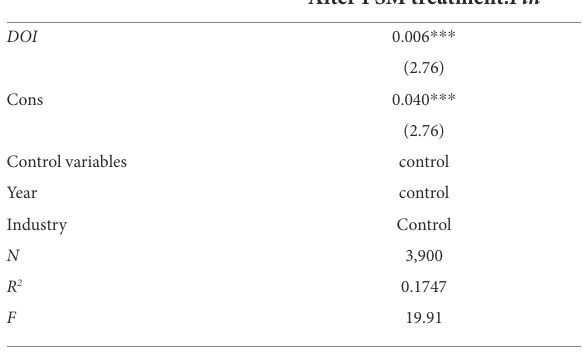
TABLE 6 Regression results of the sample after PSM treatment.